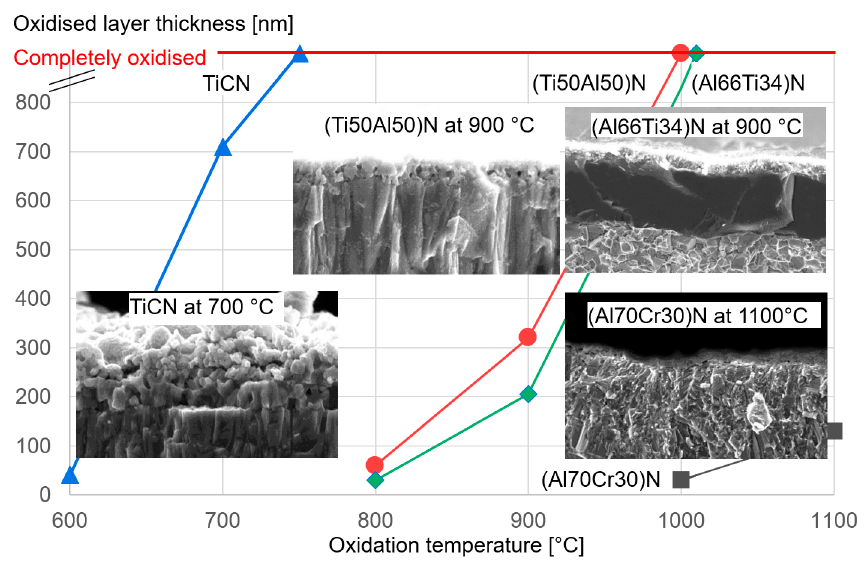
Figure 14. Thickness of the oxide layer as a function of the oxidation temperature for different industrial-standard PVD